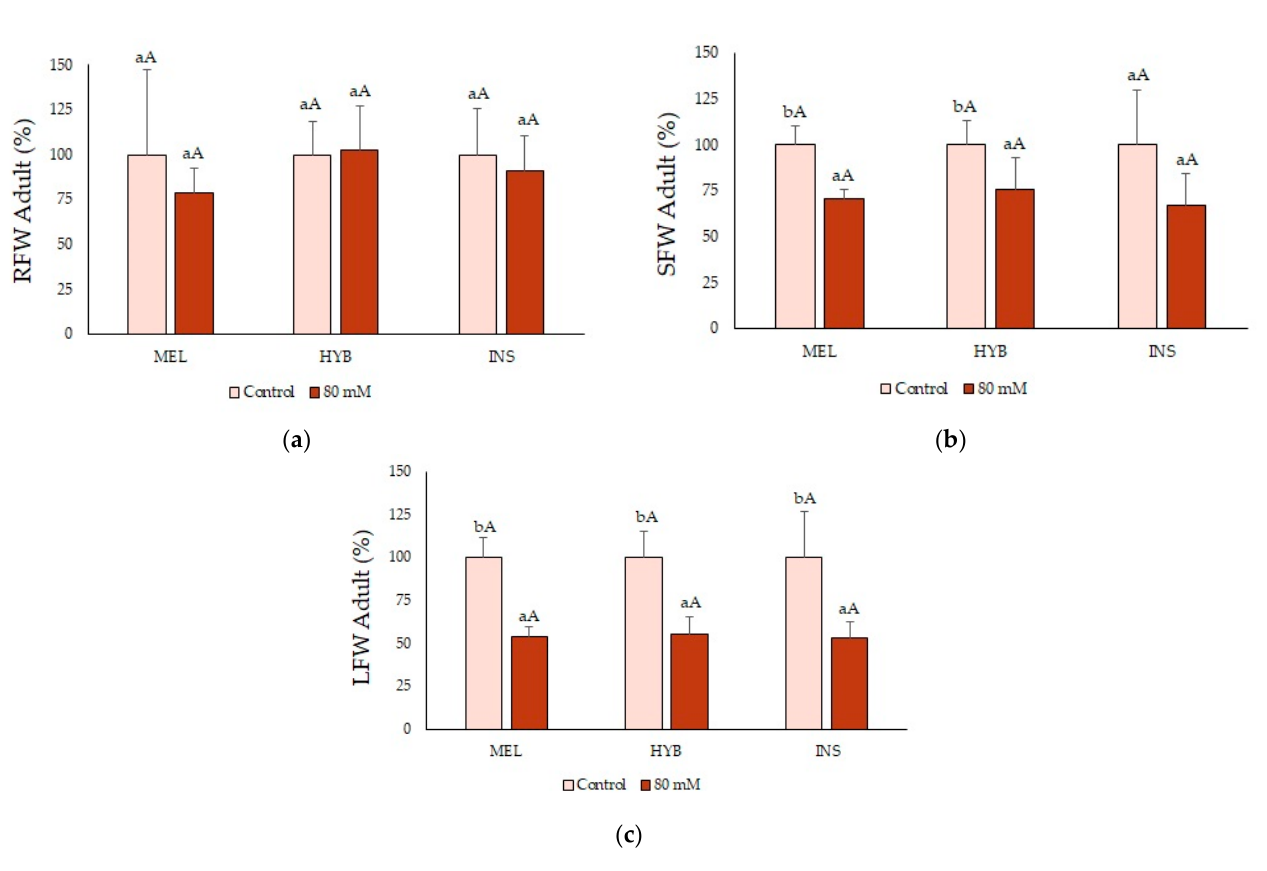
Figure 8. Root (RFW) ( a ), stem (SFW) ( b ) and leaf (LFW) ( c ) fresh weight (mean ± SD; n = 5) in adult plants of Solanum melongena (MEL), Solanum insanum (INS) and their hybrid (HYB) in control conditions and under long term (eight weeks) 80 mM NaCl irrigation. Values are shown as percentages of the corresponding controls of each genotype, taken as 100%, with absolute values for RFW (g): [MEL = 129.9, HYB = 177.4, INS = 111.2], SFW (g): [MEL = 120.1, HYB = 185.3, INS = 131.2] and LFW (g): [MEL = 130.2, HYB = 195.1, INS = 174]. Different lowercase letters within the same genotype indicate statistically significant differences between treatments, and different uppercase letters within the same treatment indicate statistically significant differences between genotypes ( p < 0.05), according to the Student–Newman–Keuls multiple range test.